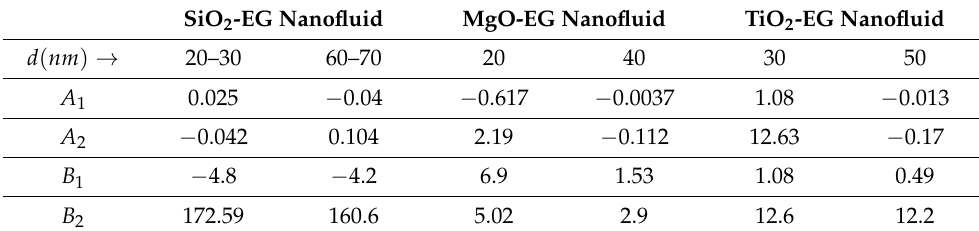
Table 1. The values of A 1 , A 2 , B 1 , and B 2 for different nanofluids at different particle diameters. SiO 2 -EG Nanofluid MgO-EG Nanofluid